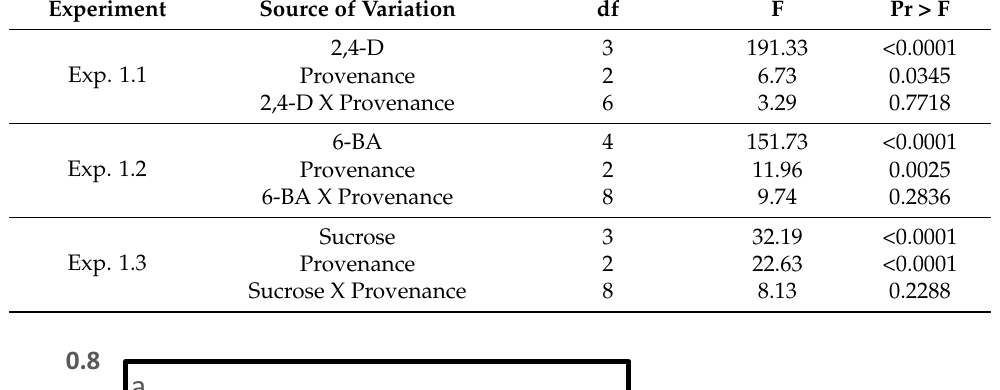
Figure 1. Initiation of embryogenic cell mass of the provenance F1 in Picea pungens SE under various